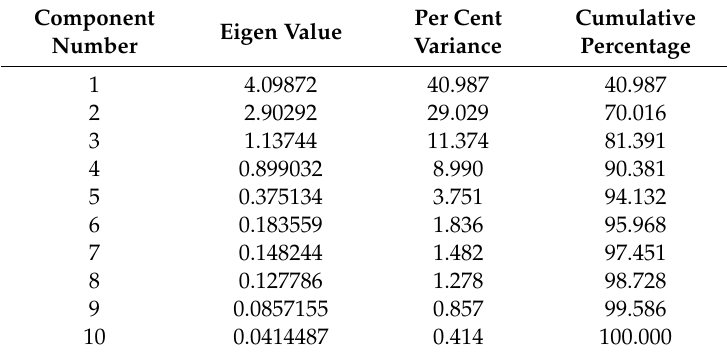
Table 6. Principal Components Analysis.